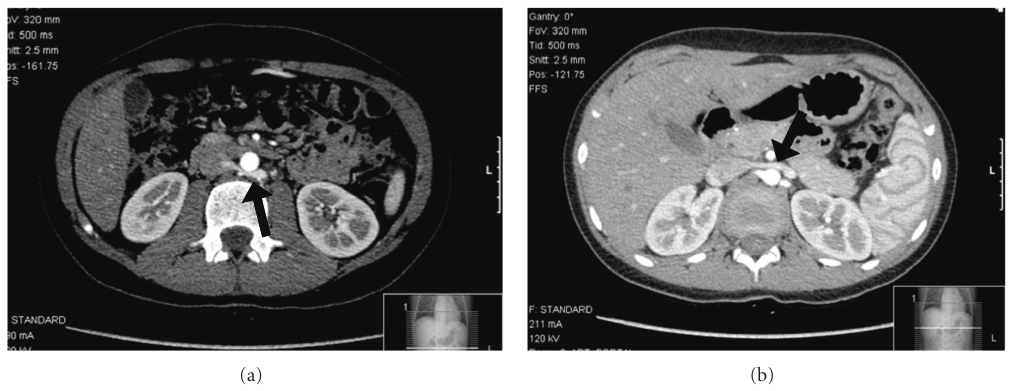
Figure 3: (a) Posterior branch of the left renal vein entrapment; (b) normal anterior left renal